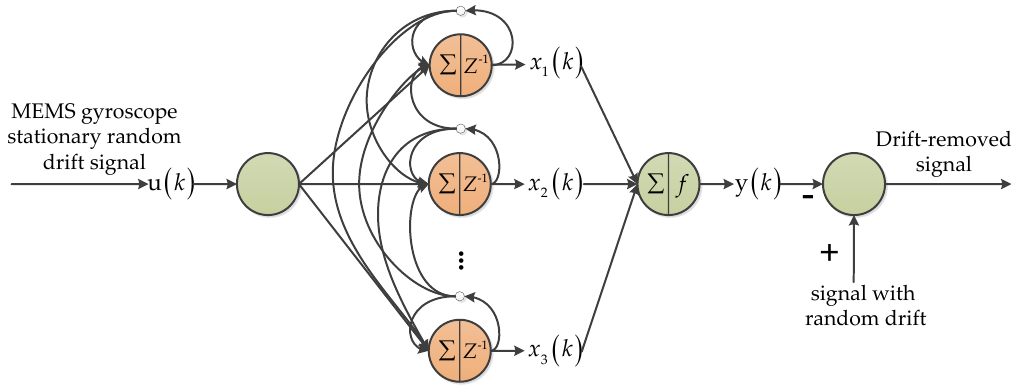
Figure 16. The random drift modeling and compensation process through the Wiener-type recurrent neural network [69].